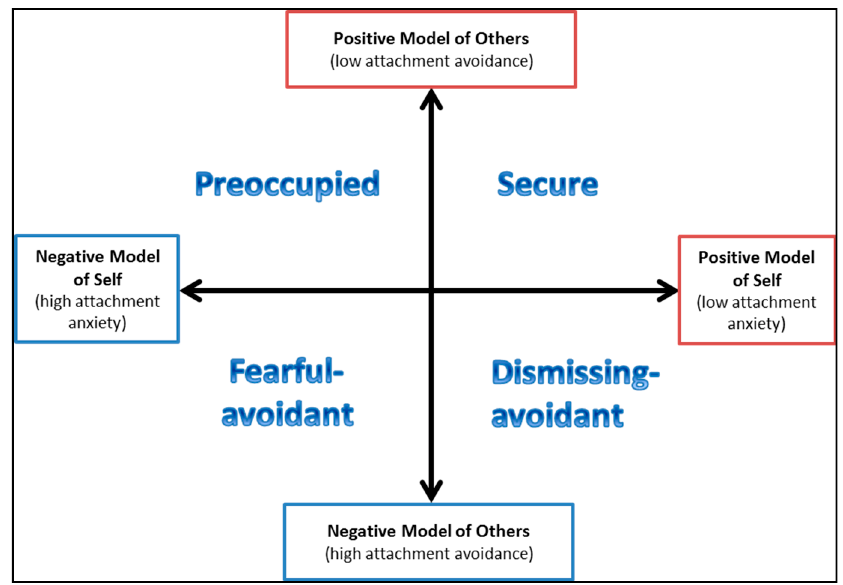
Figure 1. Different attachment styles described by Griffin and Bartholomew [15] .